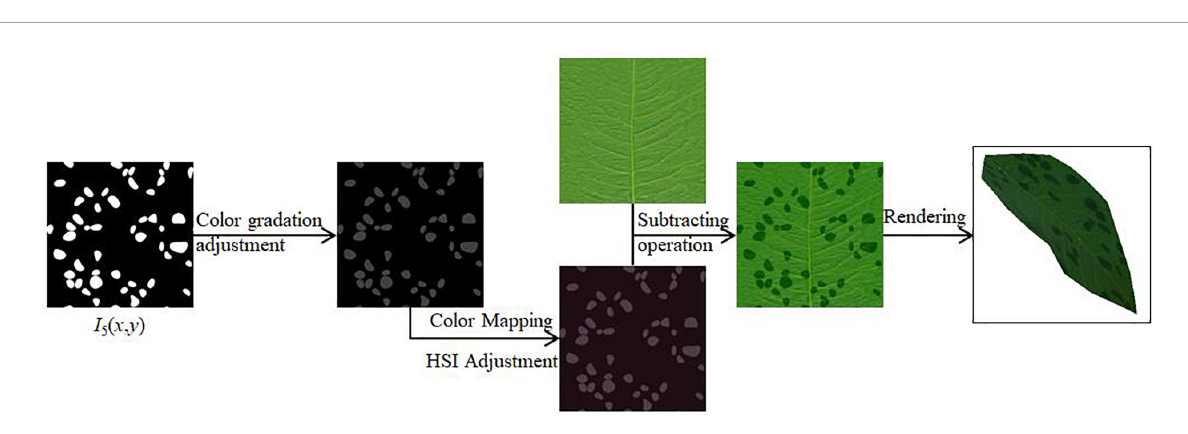
FIGURE7 Schematic diagram of rose black spot